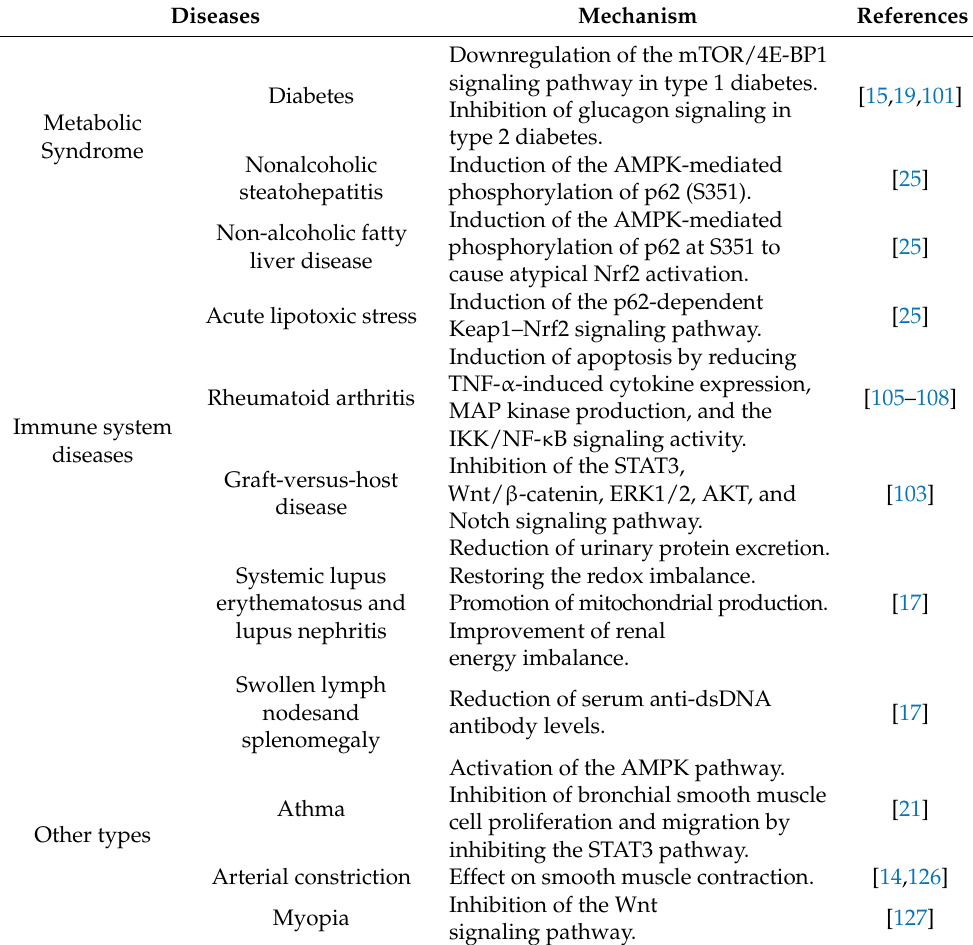
Table 2. The pharmacological activities and mechanisms of NIC and its derivates in metabolic syndrome, the immune system, and other types of diseases.